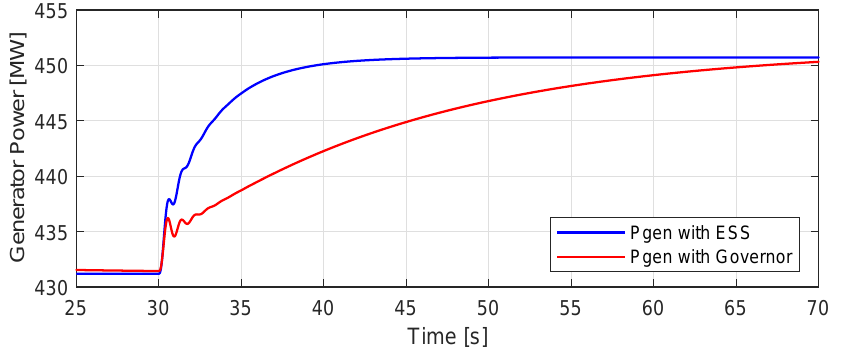
Figure 10. Comparison of measured power response between Governor and ESS on generator against frequency step change.